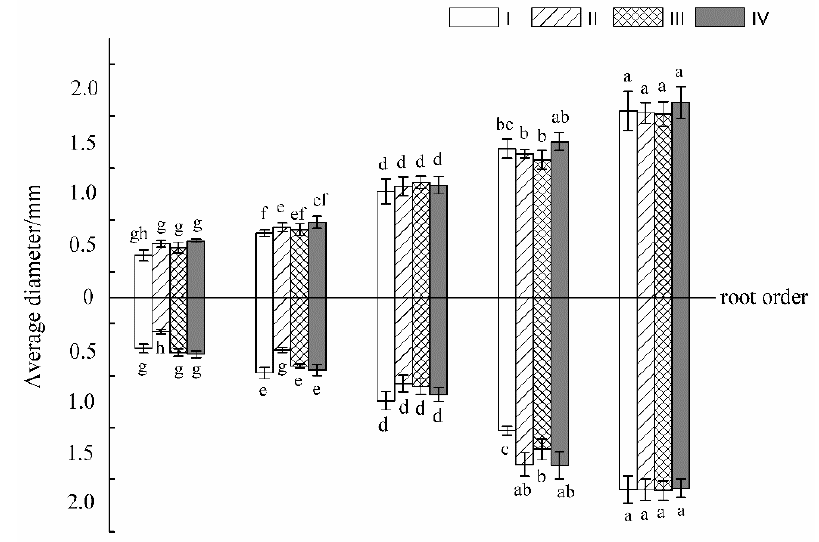
Figure 2. The effect of crop tree management on the root average diameter at different distances from the target Pinus massoniana . The X axis is the first to the fifth root order. The bars above the X axis represent the crop trees, and the bars below the X axis represent noncrop trees. I, II, III, and IV represent the distance of fine roots to the target tree at 0–0.5, 0.5–1, 1–1.5, and 1.5–2 m (this applies to Figures 1–5). Each bar represents the mean ± SD with three replicates. Different letters above or below each bar indicate significant differences among groups compared by Fisher’s LSD test at p < 0.05.